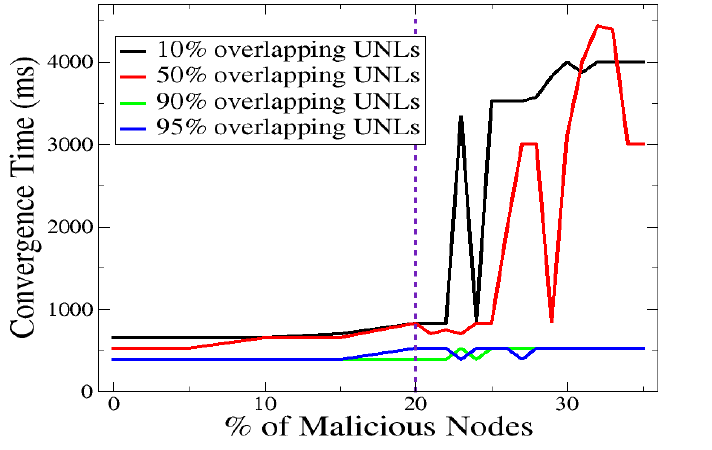
Figure 1. Convergence time vs. percentage of malicious nodes for various UNL